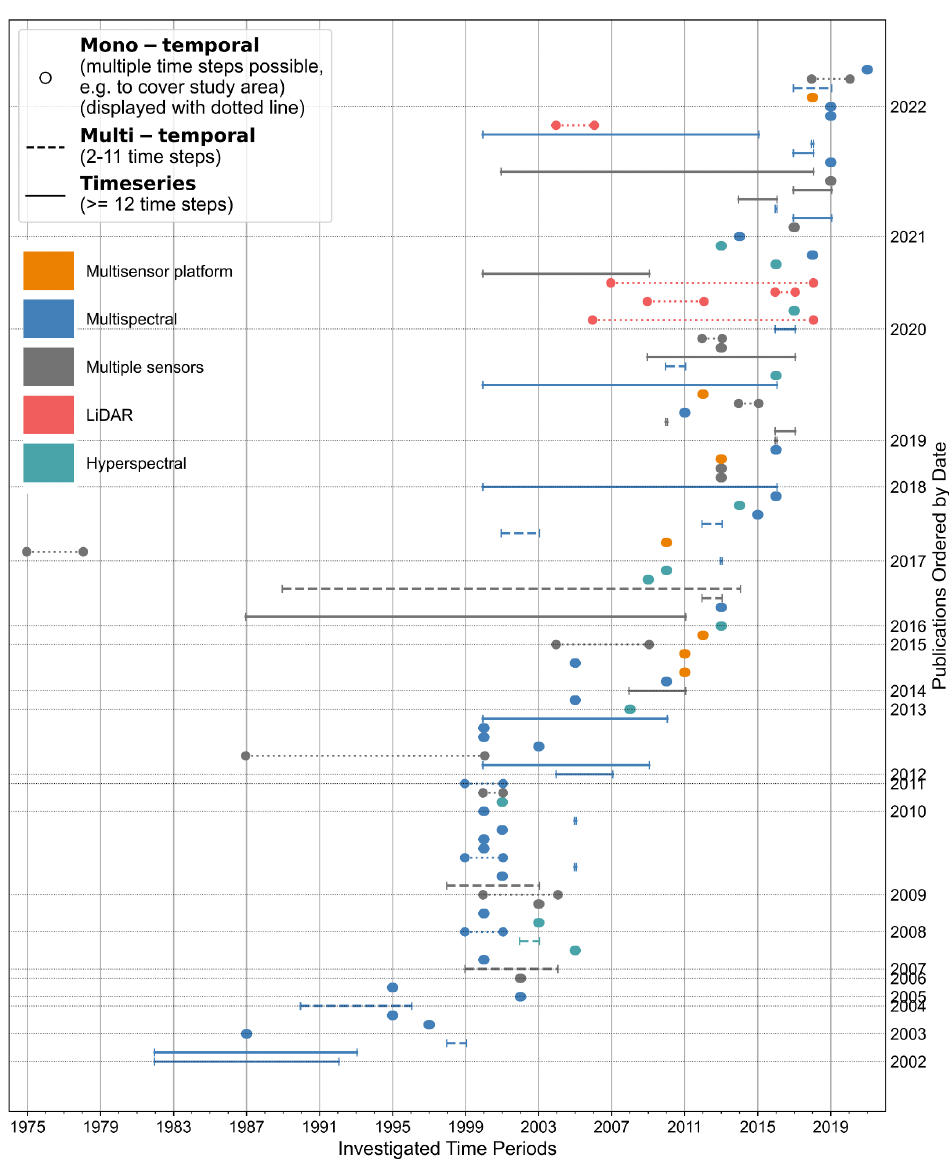
Figure 9. Analysis on the investigation periods of remote sensing data in comparison to the publica- tion year of all reviewed studies. Remote sensing data sets are classified per study into hyperspectral imagery, LiDAR observations, data from multiple sensors (combination of different remote sens- ing sensors in a study), multispectral imagery, or data from a multisensor platform (simultaneous acquisition of different remote sensing sensors from a single airborne platform). In some cases, mono-temporal approaches are displayed over a time period (dotted line) since multi-temporal remote sensing data sets were combined, e.g., for a complete coverage of the study